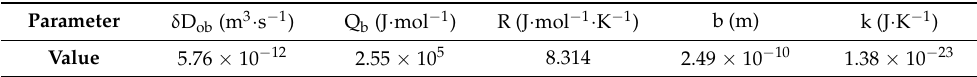
Table 5. Material parameters related with the calculation of grain boundary mobility.